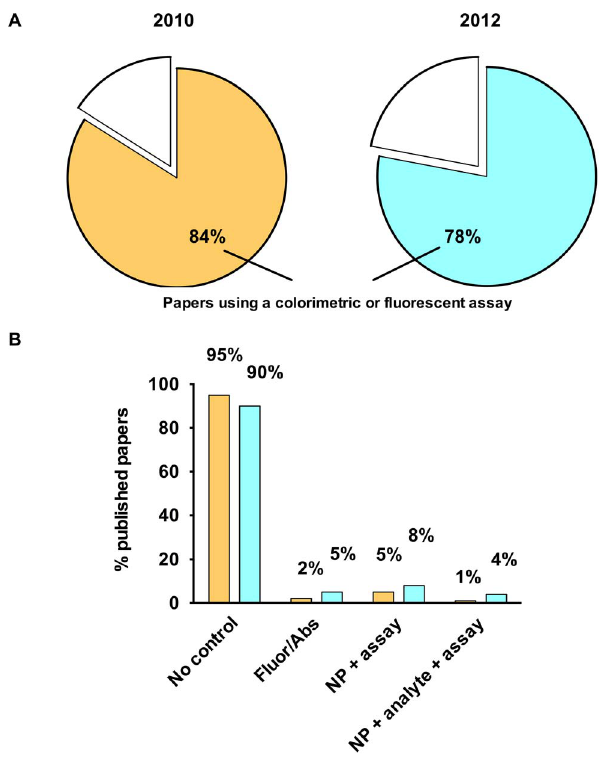
Figure 5. Literature survey to determine the percentage of papers testing for nanoparticle interference in spectroscopic- based assays. (A) Percentage of published papers that use a toxicity assay based on measurement of colorimetric or fluorescent change in either 2010 or 2012; (B) Breakdown of controls performed in papers using one of these assays. (note: Percentages do not add up to 100% due to overlap in papers performing more than one control).